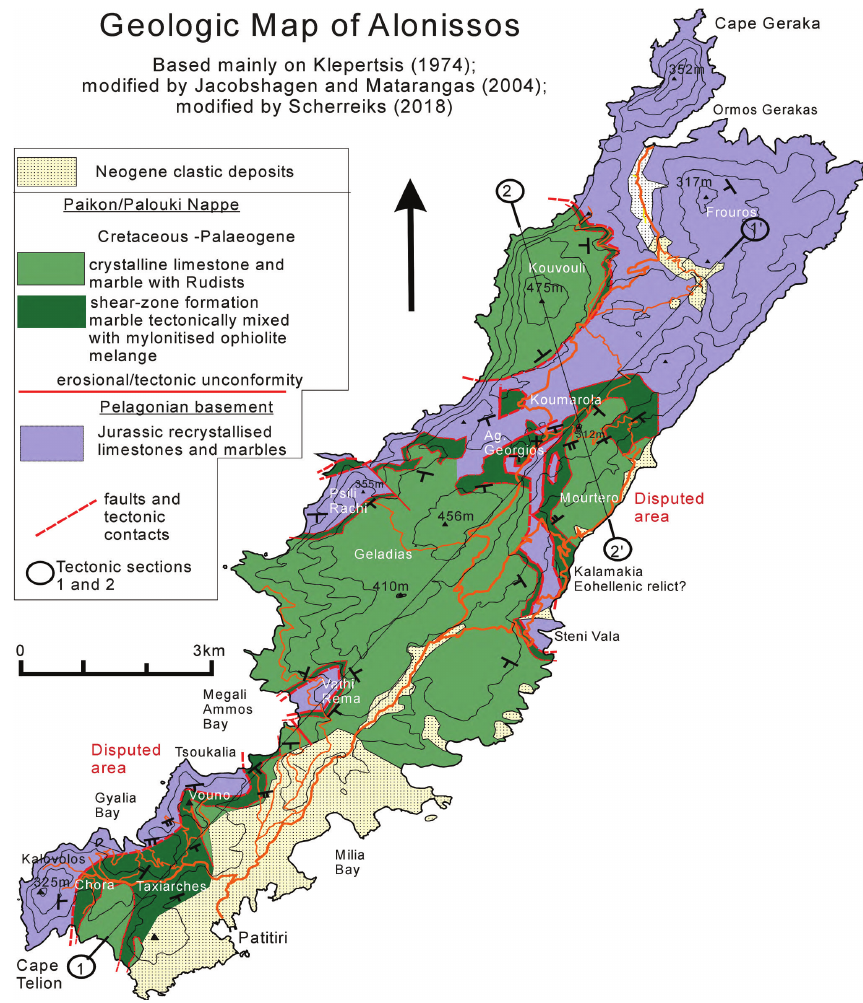
Geologic map of alonnisos. On alonnisos, Jurassic crystalline limestones and marbles are the oldest outcropping rocks [10]. after erosion had removed the Eohellenic nappe, the Paikon–Palouki nappe was emplaced during the Palaeocene (see Biostratigraphy). The geologic map of alonnisos mainly differs from the previous maps in two disputed areas: first, the Jurassic carbonates underlie the shear zone in the area between Cape Telion and Megali ammos Bay and second, Cretaceous rudist limestones overlie the shear zone in the area between Koumarola and